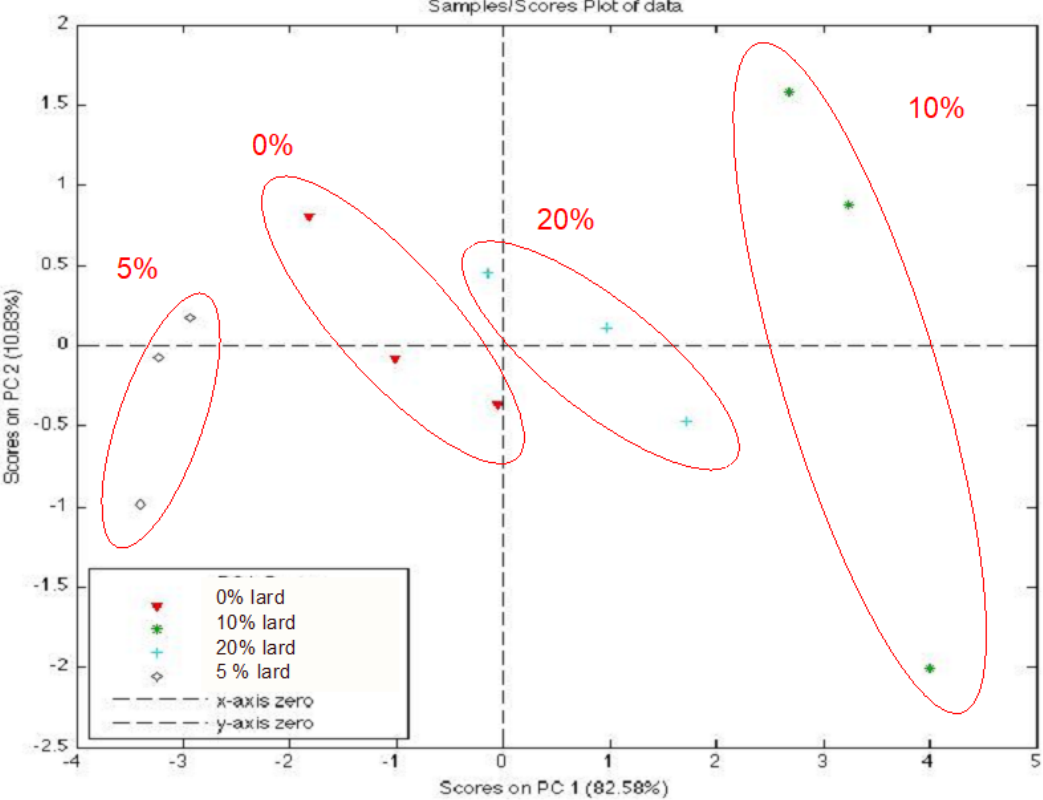
Figure 2. Principal component analyses (PCA) scores on porphyrins-based EN analysis on ḥ alāl goat meat dough added with pork fat (0%, 5%, 10% and 20% of lard, w / w ).